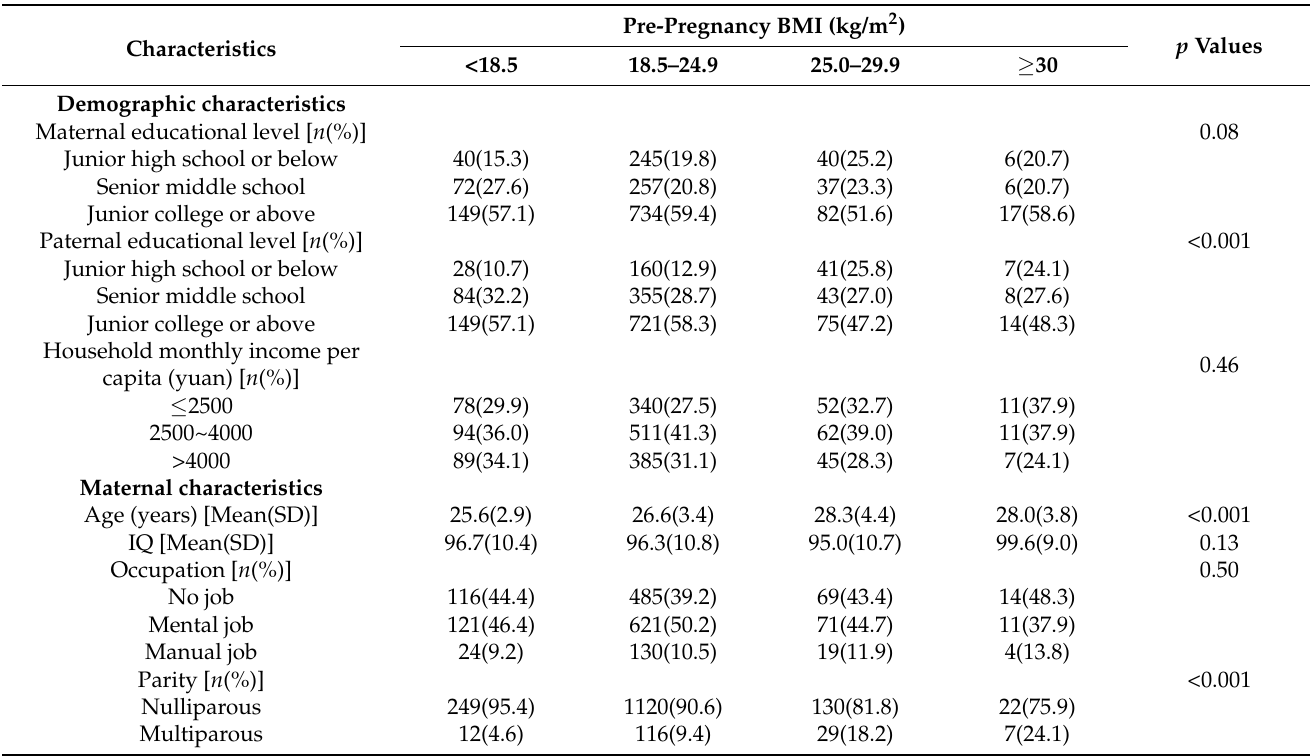
Table 1. Baseline characteristics of the